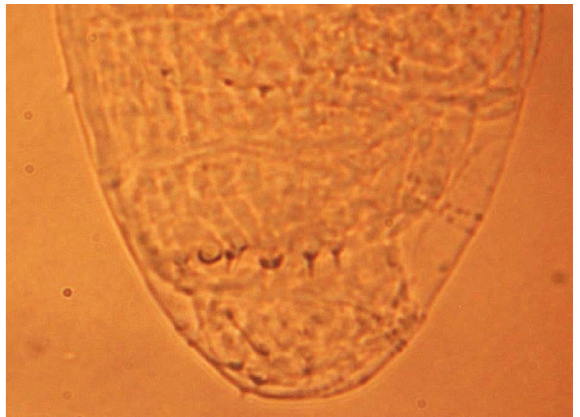
Figure 9: The head, neck, and prothorax (with spiracles) of the second instar. The spatula is absent. The dorsal and pleural papillae are setiform. The sternal and lateral papillae are